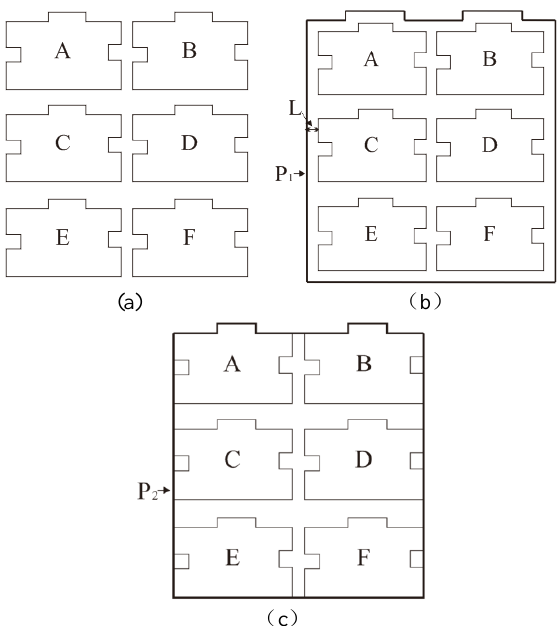
Figure 6. Dilation and erosion transformations. (a) Original pattern; (b) dilation transformation; (c) erosion transformation.